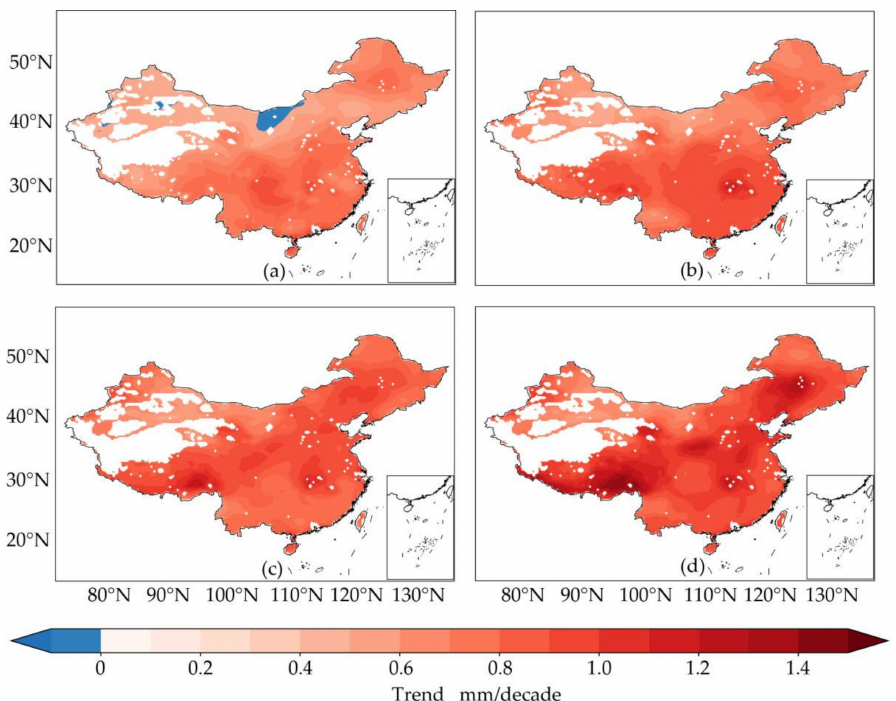
Figure 5. The yearly trend of future evaporation change from 2021–2100 in different scenarios. ( a – d ) correspond to the SSP1–2.6, SSP2–4.5, SSP3–7.0 and SSP5–8.5 scenarios,